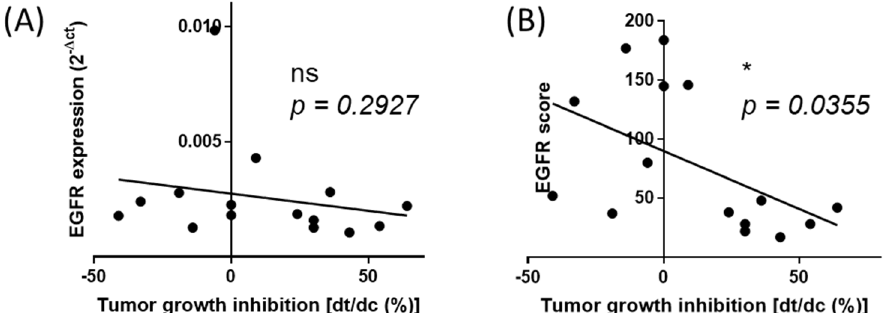
Figure 6. The normalized score of expression of EGFR correlates with Cetuximab (anti-EGFR) efficacy. ( A ) Correlation of the non-normalized expression of EGFR expression (2 −ΔCt ) with Cetuximab tumor growth inhibition in the cohort of 15 patient-derived tumor xenografts models. ( B ) Correlation of the EGFR score (sum of 2 −ΔΔCt further normalized to 1000) with Cetuximab tumor growth inhibition in the cohort of 15 patient-derived tumor xenografts models. dt%/dc% index is used as an exact value of Cetuximab efficacy. Spearman r analysis was applied.